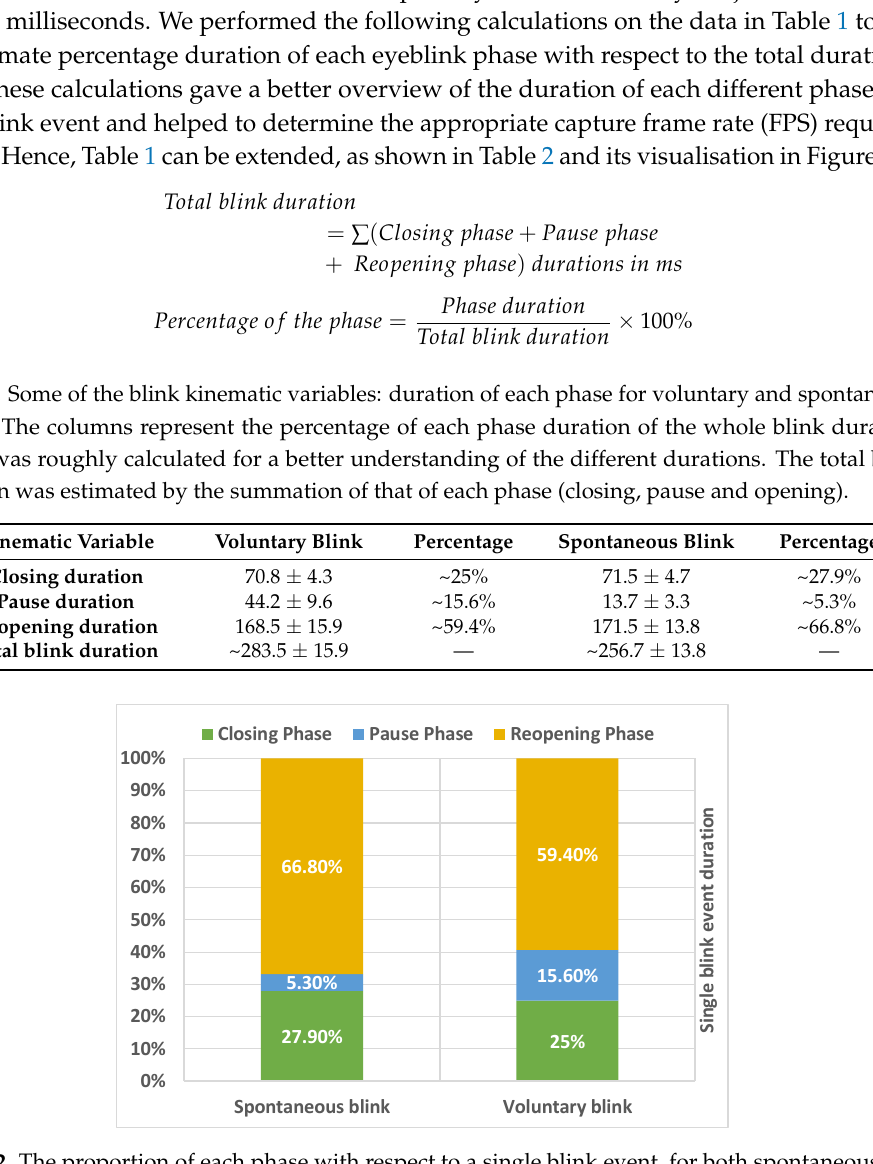
Figure 2. The proportion of each phase with respect to a single blink event, for both spontaneous and voluntary eyeblinks. The calculated values are based on a dataset for healthy controls collected during a study conducted by [11].